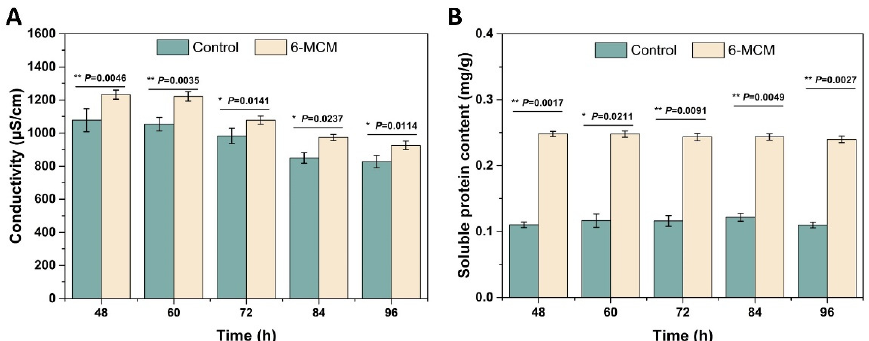
Figure 4. Effects of 6-methylcoumarin on extracellular conductivity ( A ) and soluble protein content ( B ) from V. mali mycelia during the incubation for 48 to 96 h. V. mali was cultured in the PDB containing 10% Tween-80 (as a control) and 105 mg/L 6-methylcoumarin solution, respectively. The bars represent the standard error of the mean (n = 3), and the asterisks indicate that significant dif ‐ ferences exist between 6 ‐ MCM treatment and control using an independent ‐ sample t ‐ test of 6 ‐ MCM. 6 ‐ MCM, 6 ‐ methylcoumarin.